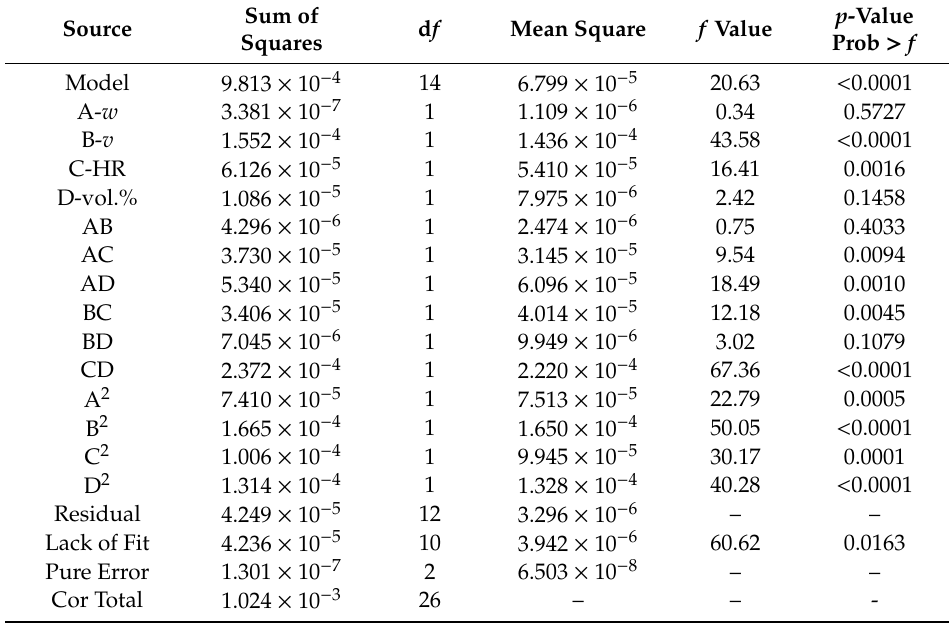
Table A1. The ANOVA model validation for wear